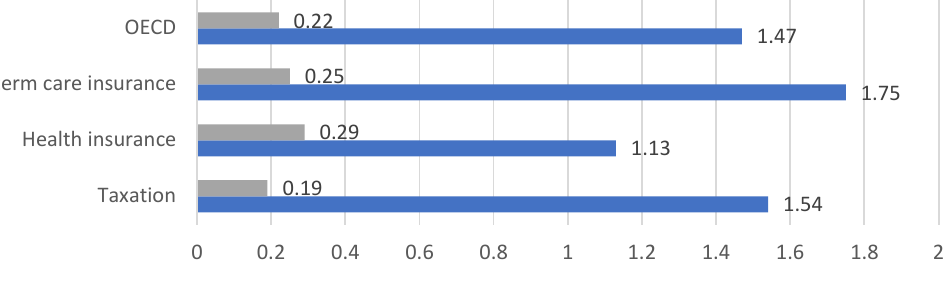
Figure 3. Total long-term care expenditure and household expenditure as a percentage of GDP [18,25].